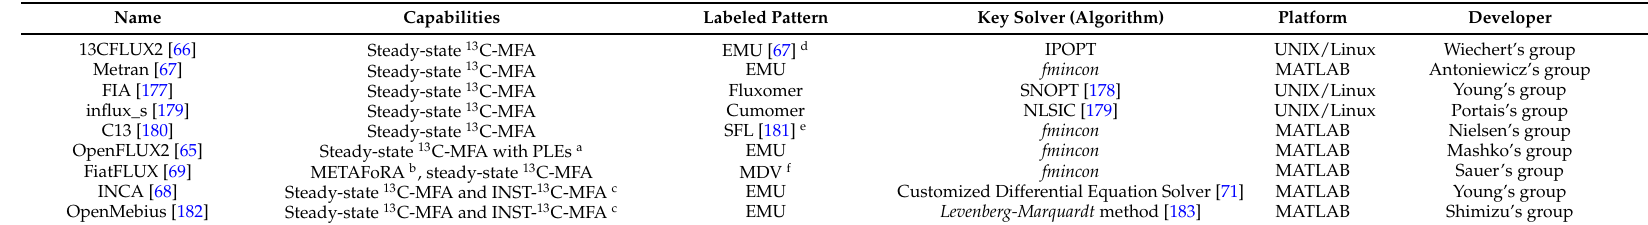
Table 1. Summary of 13 C-MFA software.